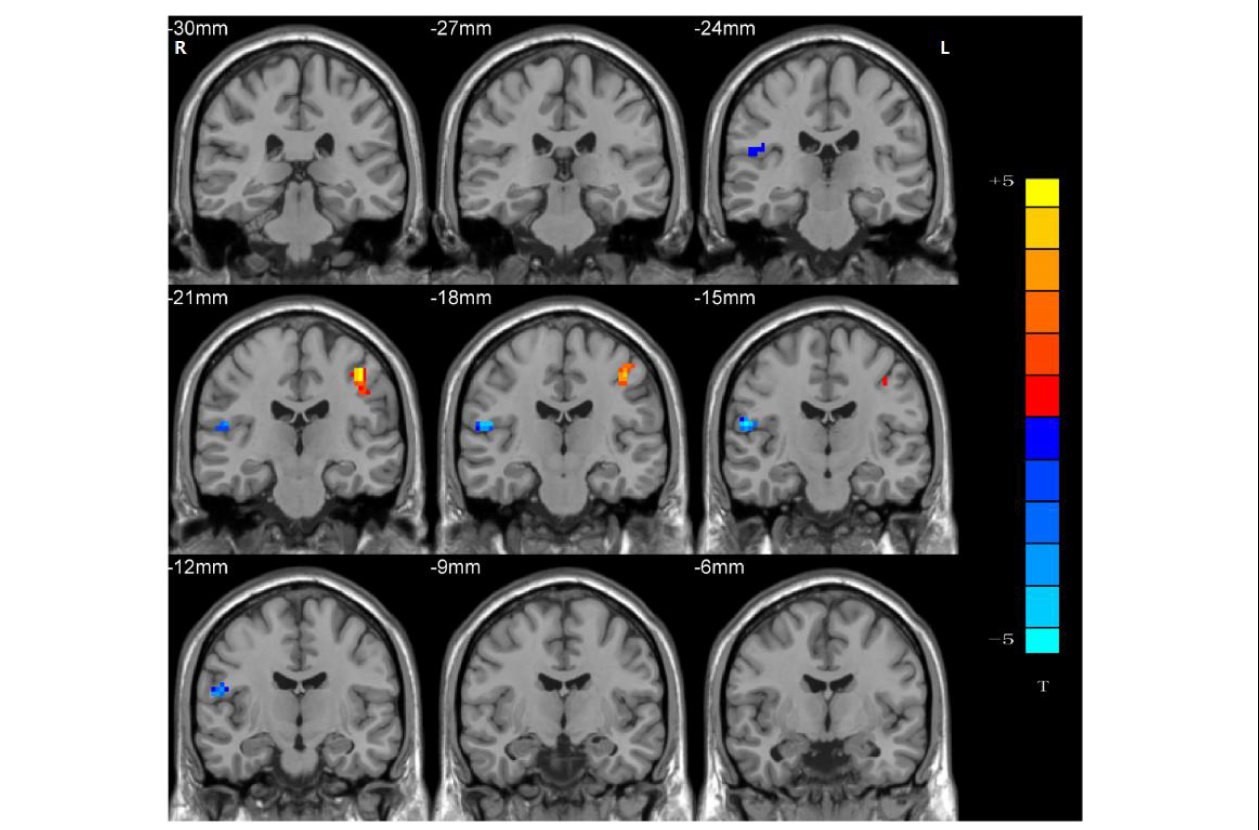
FIGURE 3 | Statistical maps showing NH differences in the left postcentral gyrus and the right Rolandic operculum between the lTLE group and the control group. (Blue indicates lower NH and the color bar indicates the t -values from the two-sample t